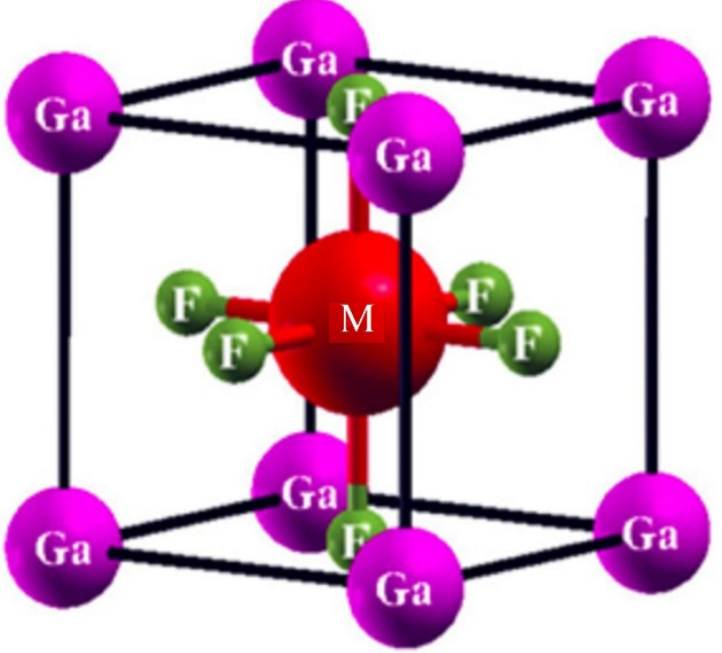
Figure 1. The prototypical crystal structure of the ternary compound, GaMF 3 (M = Ge and Be).